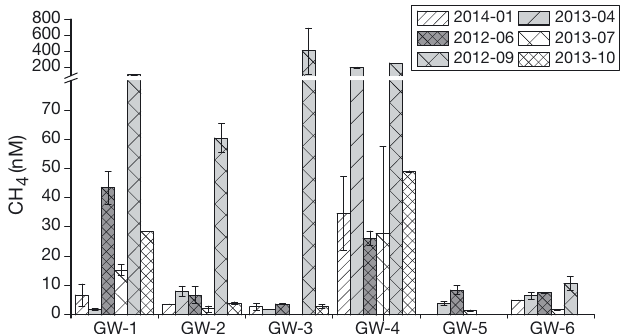
Fig. 5. CH 4 concentrations in groundwater measured at 6 stations (GW1−GW6) along the shoreline of Sanggou Bay in